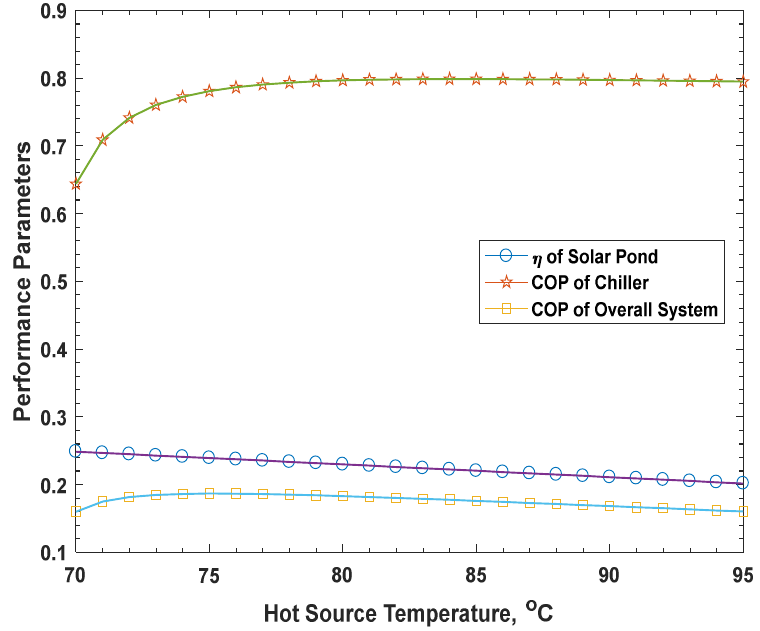
Figure 10. Effect of hot source temperature on the performance of the overall system.